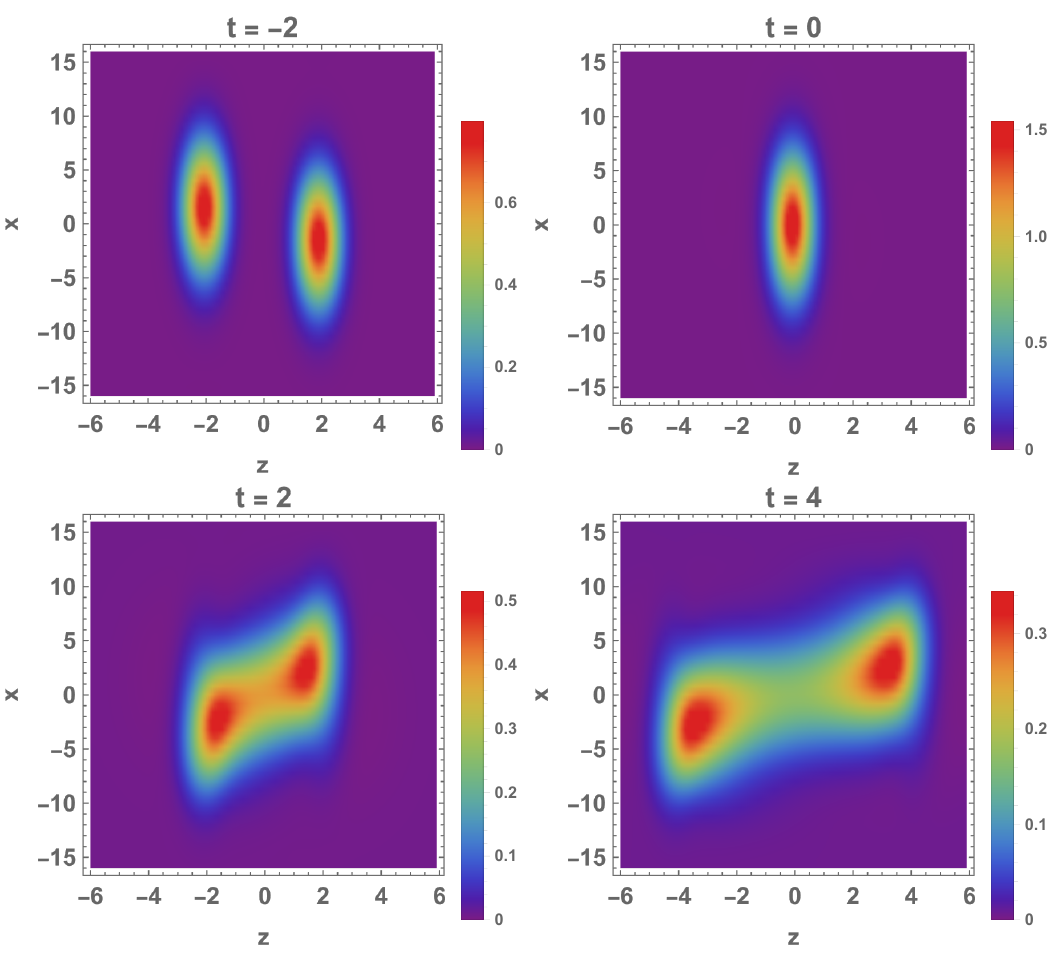
Figure 10 . The energy density T 00 at zeroth order, for times t = − 2 , t = 0 , t = 2 and t = 4 (from top left to bottom right), and at y = 0 . First order corrections to T 00 are negligible.